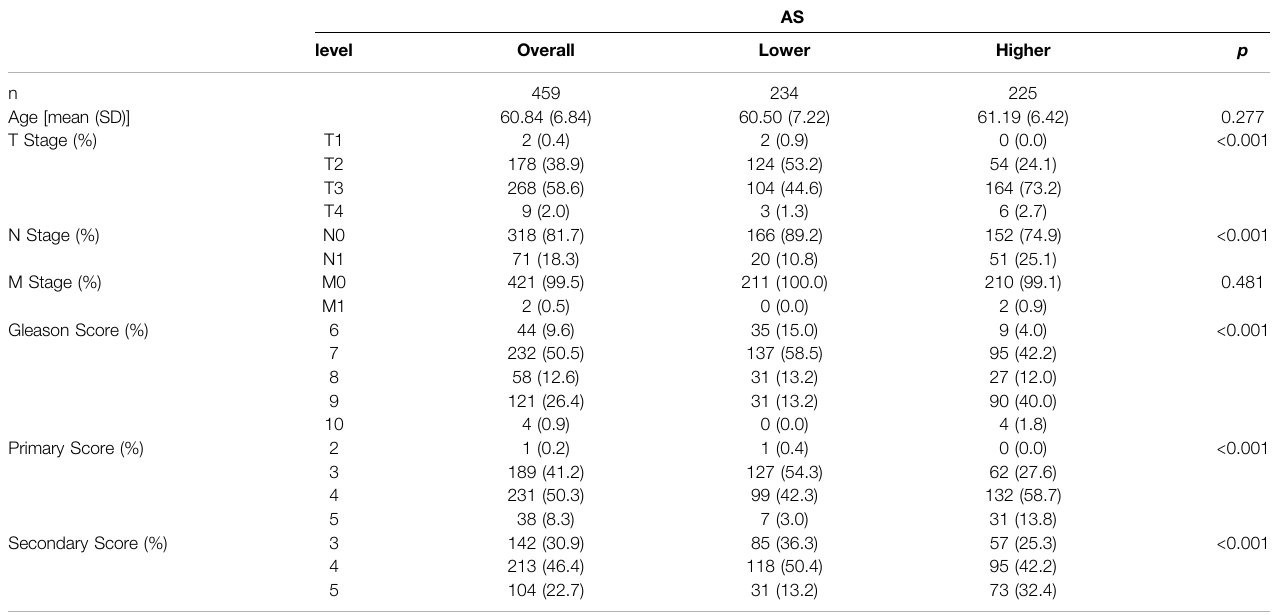
TABLE 1 | Association of aneuploidy with clinical characteristics in PCa. AS level Overall Lower Higher